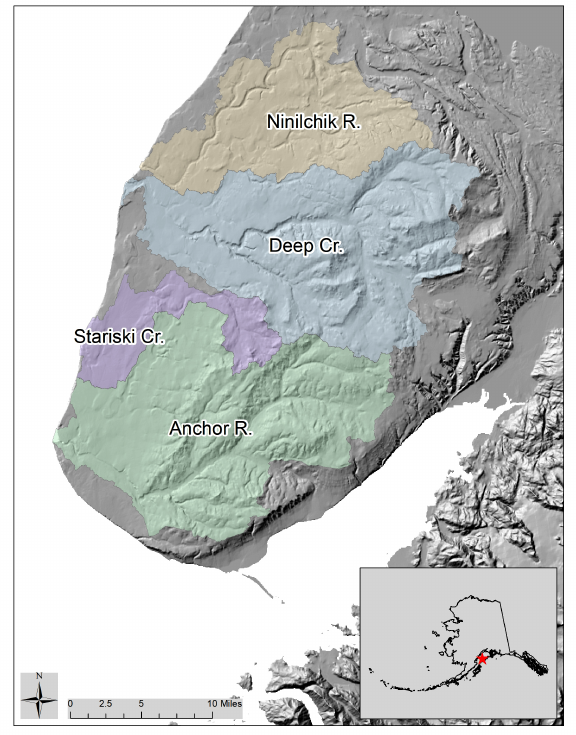
Fig. 1. Map showing the location of the Kenai Lowlands region on the southern end of the Kenai Peninsula in south-central Alaska, USA. The region encompasses four major watersheds, indicated by the four different colors.